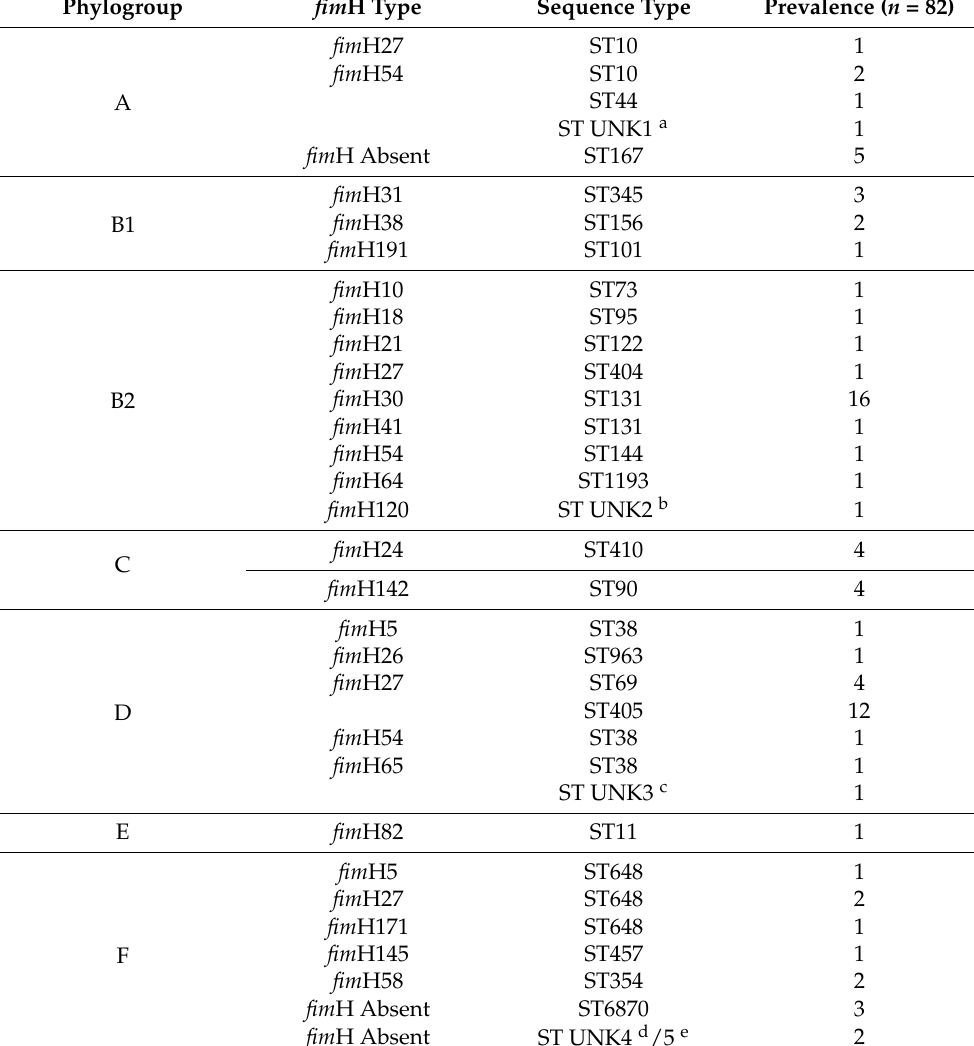
Table 1. Distribution and prevalence MLST and fimH types in groups of CRE isolates. Phylogroup fim H Type Sequence